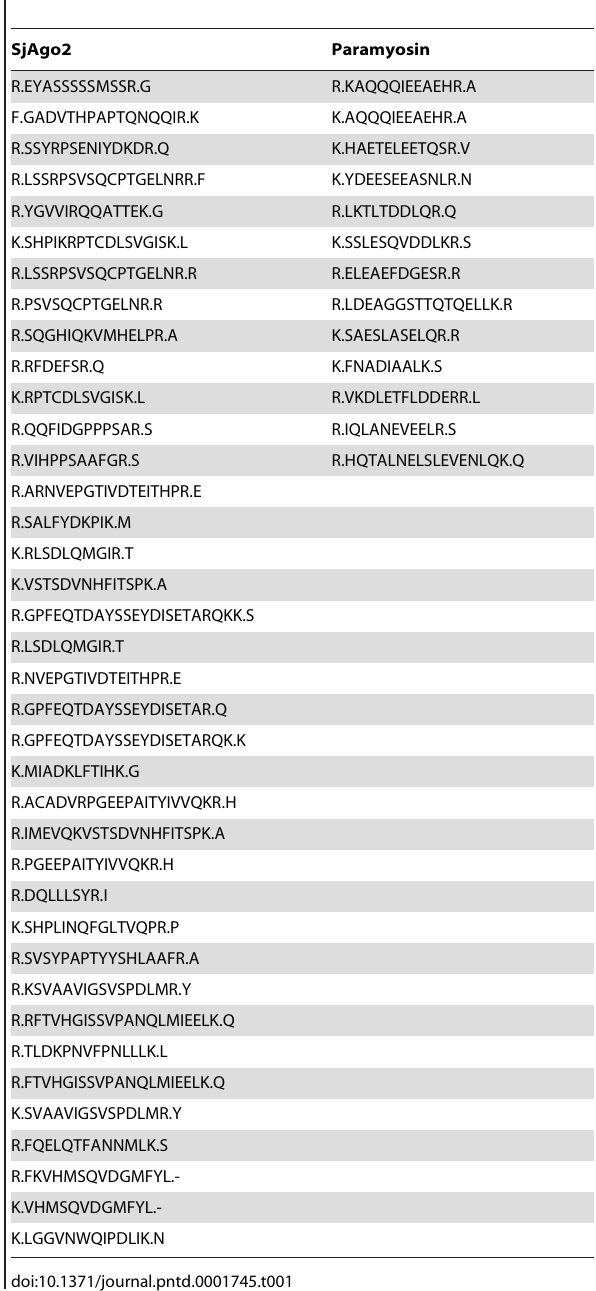
Table 1. Peptide sequences from SjAgo2 and paramyosin identified by Orbitrap MS from 27A9